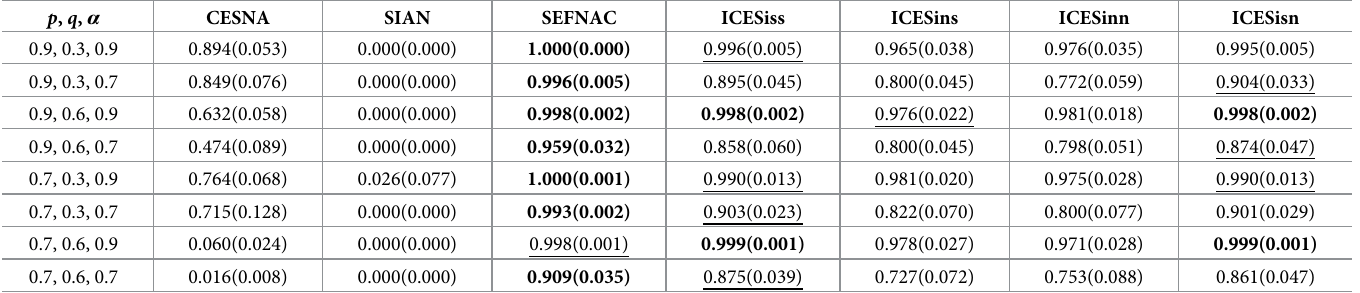
Table 11. The comparison of CESNA, SIAN, SEFNAC and ICESi methods at medium-size synthetic data sets with categorical attributes: The average ARI index and its standard deviation over 10 different data sets. p , q , α CESNA SIAN SEFNAC ICESiss ICESins ICESinn ICESisn 0.9, 0.3,